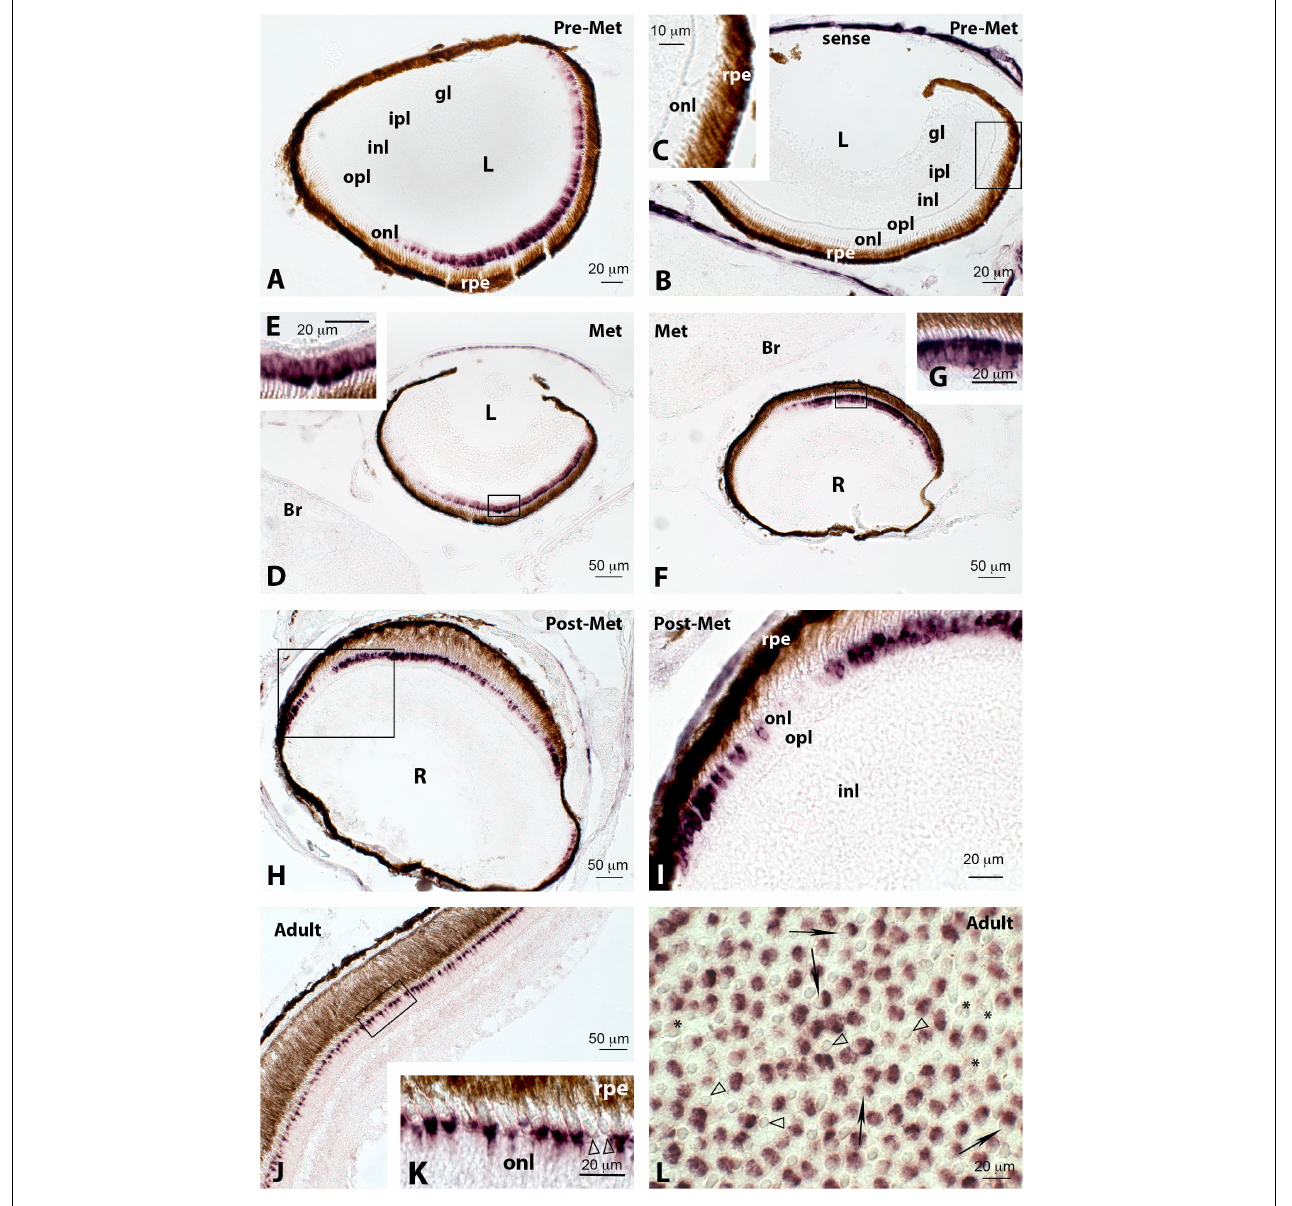
FIGURE 11 | Localisation of red cone opsin ( lws ) expression in the retina of pre-metamorphic (Pre-Met; A–C ), metamorphic (Met; D–G ), post-metamorphic (Post-Met; H,I ), and adult (J–L) Senegalese sole specimens revealed by in situ hybridisation. All the photomicrographs represent antisense sections, with the exception of panels (B,C) , which show sense control sections. Squares in panels (B,D,F,H,J) mark the areas magnified in photomicrographs (C,E,G,I,K) , respectively. Note that some parts of the retina (dorsal margin) appear devoid of labelling in pre-metamorphic (A) and metamorphic (D,F) specimens, both in the left and right retinas. Positive red opsin-expressing cells become evident in the dorsal retina of post-metamorphic animals (H,I) . In the adult retina, this expression is evident in double cones, with smaller single cones being devoid of labelling ( K,L , white arrowheads). Some double cones appear unlabelled ( L , asterisks) while others only exhibit one of the pairs labelled ( L , black arrows). All pictures corresponded to radial sections, with the exception of (L) that represents a tangential section. For abbreviations, see the legend in Figure 2 . Scale bars represent 10 µ m in panel (C) ; 20 µ m in panels (A,B,E,G,I,K,L) ; and 50 µ m in panels (D,F,H,J)